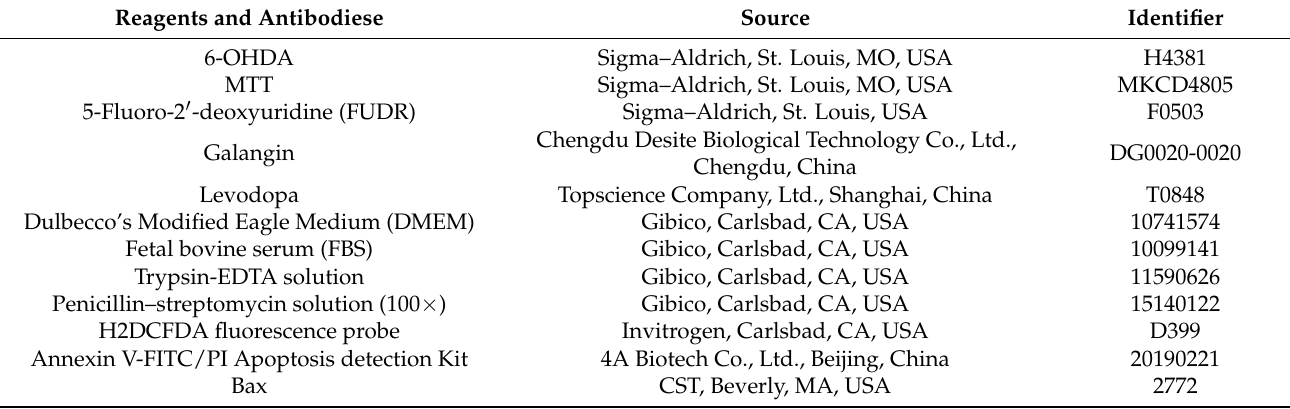
Table 2. The materials and reagents used in the